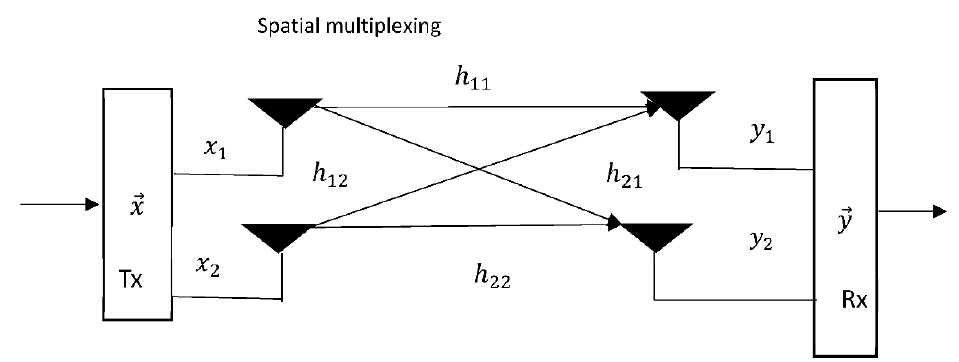
Figure 15. Schematic presentation of spatial MIMO.